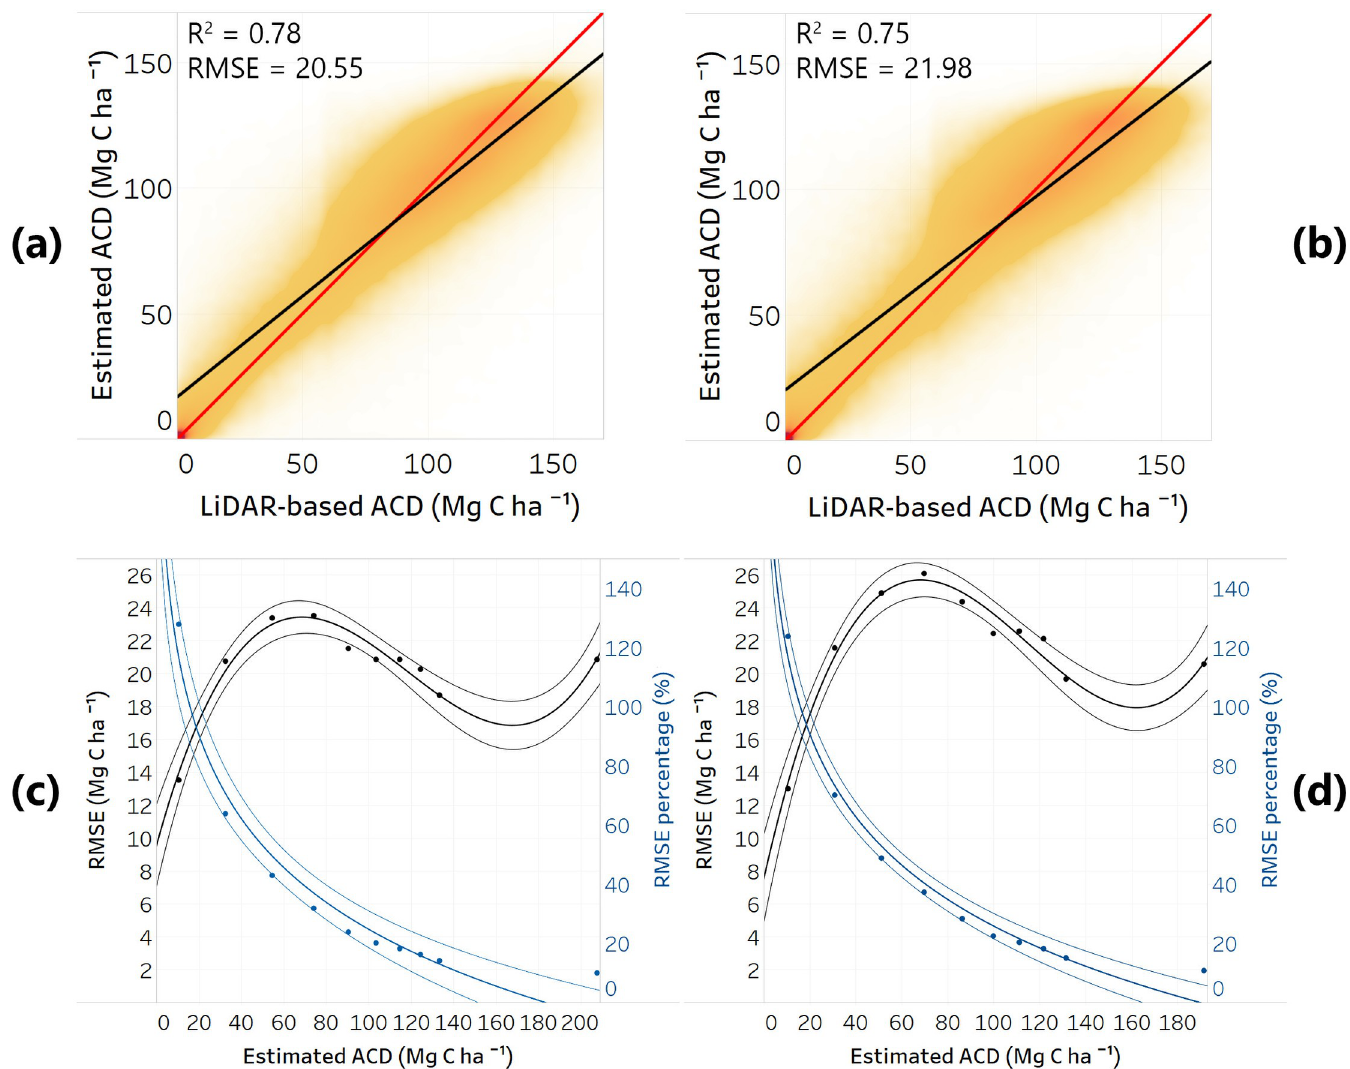
Fig 1. Density scatter plots between our deep learning model-estimated ACD against 20% hold-out airborne LiDAR-based ACD (Mg C ha -1 ). Here are shown (a) the highest accurate model, Q3 of 2017 and (b) the least accurate model, Q1 of 2018. The 1:1 line is shown with red and the trend line is shown with black. R 2 and RMSE (Mg C ha -1 ) values are shown in the upper left part. In (c) and (d) are shown the absolute RMSE (Mg C ha -1 , black) and relative RMSE (%, blue) values from the estimated ACD for the two models shown in (a) and (b) , respectively. These uncertainties were obtained by grouping the RMSE values in 10 bins and fitting polynomial and logarithmic functions for the absolute and relative RMSE, respectively. Applied on each 1-ha pixel, these fitted functions gave maps of continuous variation of ACD estimation uncertainty. Each trend line depicted represents the fitted function with confidence intervals.